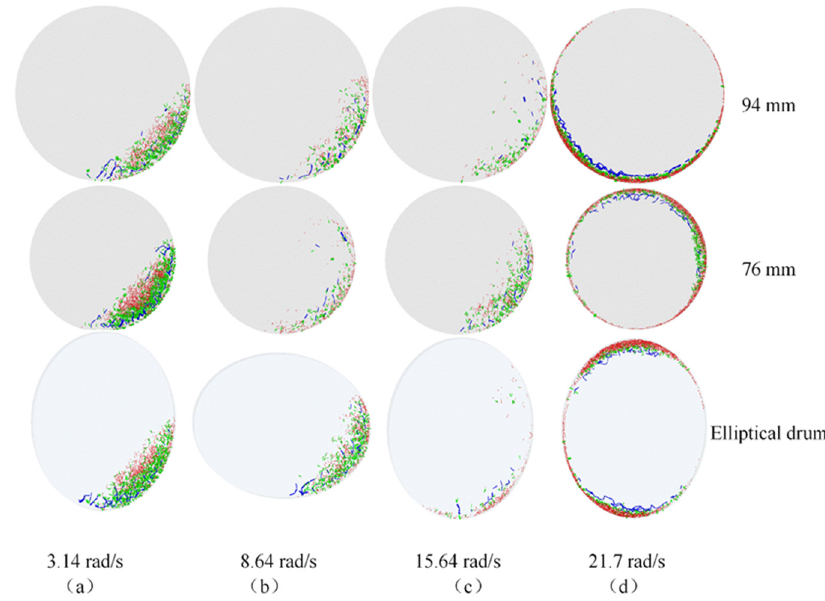
Figure 4. Normal force at different rotational speeds.